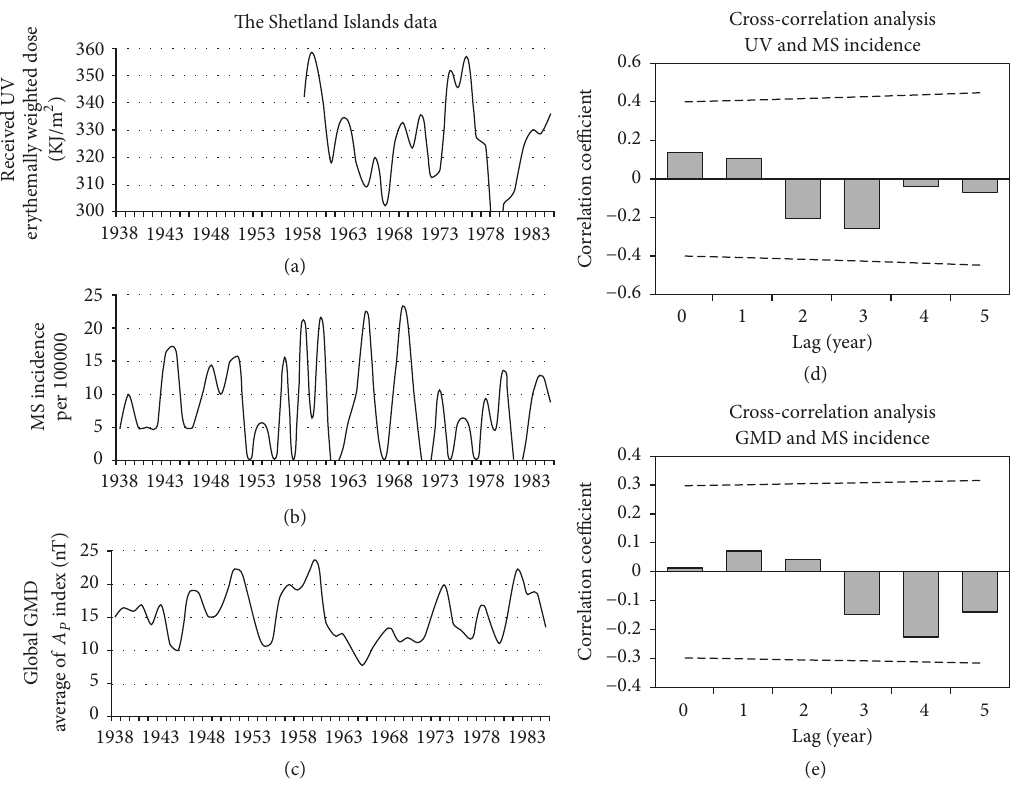
Figure 4: The Shetland Islands data. Panel (a): annual average of the received UV (1958–85). Panel (b): MS incidence of the Shetland Islands (1938–85), adapted from the report of Cook et al. [13]. Panel (c): annual average of global GMD based on the 𝐴 𝑝 index (1938–85). Panel (d): the result of lagged correlation between received UV and MS incidence. Panel (e): the result of lagged correlation between GMD and MS incidence. The dashed lines in those panels (d and e) are the threshold for significant correlation. The horizontal solid lines in these panels indicate coefficient of correlation (𝑟) = 0